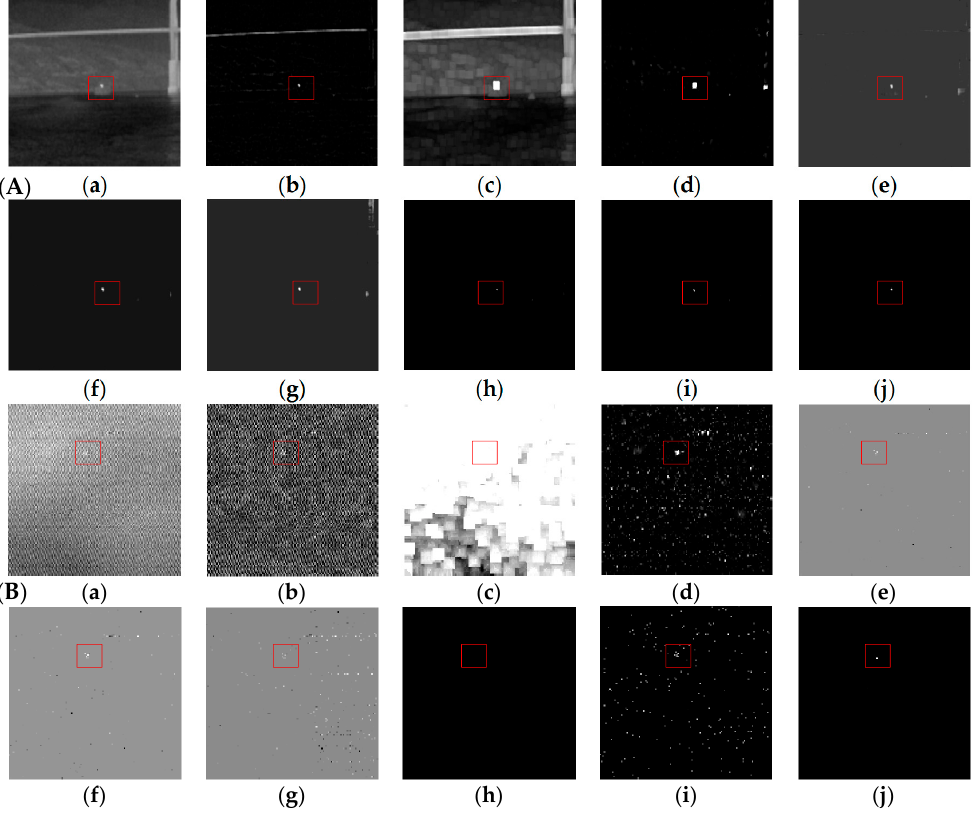
Figure 10. Results of different approaches to Scenes 7 and 8. ( A ) Scene 7; ( B ) Scene 8; ( a ) Original image; ( b ) Tophat; ( c ) LCM; ( d ) MPCM; ( e ) IPI; ( f ) NIPPS; ( g ) ReWIPI; ( h ) SMSL; ( i ) RIPT; ( j ) NRAM.